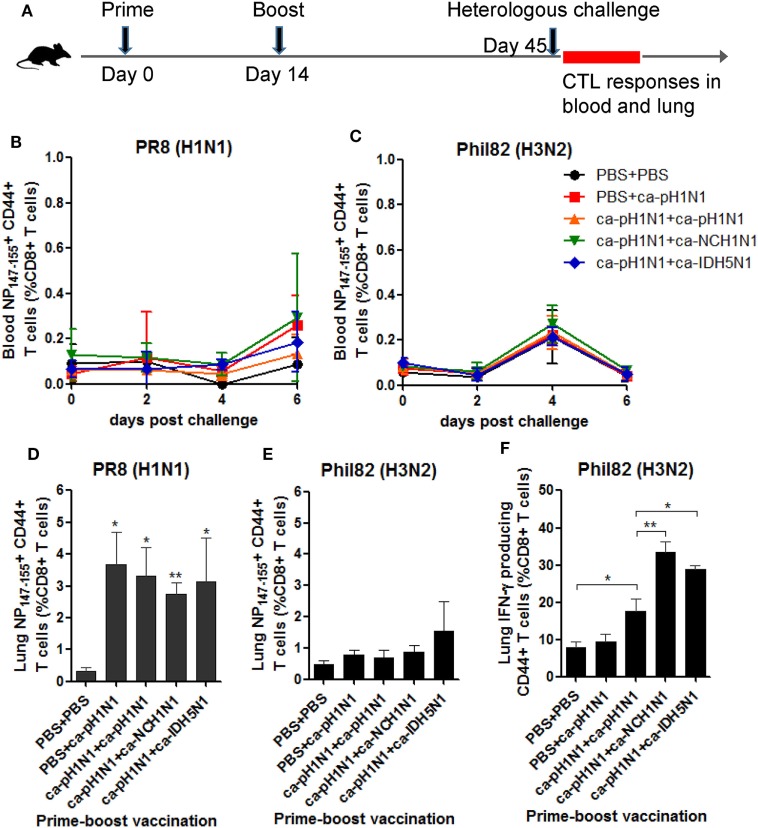
Recall response of CD8+ cytotoxic T lymphocytes (CTLs) upon heterologous challenge. (A) Mouse vaccination and challenge for the analysis of CTL responses. A total of 105 PFU of each cold-adapted, live attenuated influenza vaccines (CAIVs) were administered intranasally into naive mice and then challenged with 10 mouse lethal dose 50 (MLD50) of PR8 (H1N1) or Phil82 (H3N2). For flow cytometric analysis, blood was taken from the mice at 0, 2, 4, and 6 days post-challenge (dpc), and the mice were sacrificed at 6 dpc to collect the lung cells. (B−E) Recall response of NP147-155+ CD44+ CD8+ T cells in blood (B,C) and the lungs (D,E) upon heterologous challenge with PR8 (H1N1) or Phil82 (H3N2) based on flow cytometry data of Figures S5A,B in Supplementary Material, respectively. (F) Activation of CD8+ CTLs cells to produce IFN-γ cytokine upon Phil82 (H3N2) challenge based on flow cytometry data of Figure S5C in Supplementary Material. Data are the mean of each cohort (N = 3 to 5), and error bars indicate SD. **P < 0.01; *P < 0.05 when comparing the T-cell frequencies between the vaccination group and PBS group (D,E) or between two different groups (F).